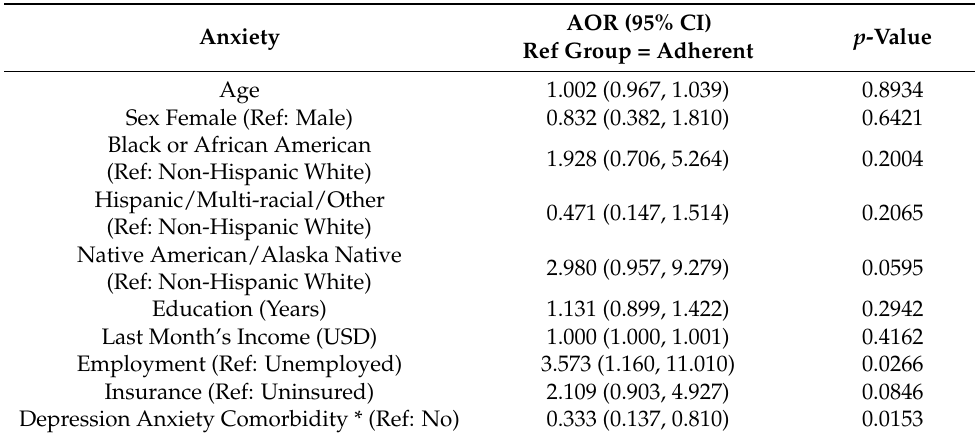
Table 4. Logistic Regression Predicting Likelihood of Reporting Medication Nonadherence—Anxiety.